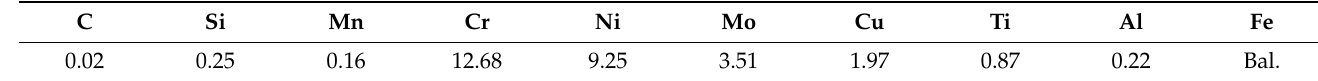
Table 1. Chemical composition of Nanoflex steel [wt.%]. C Si Mn Cr Ni Mo Cu Ti Al Fe